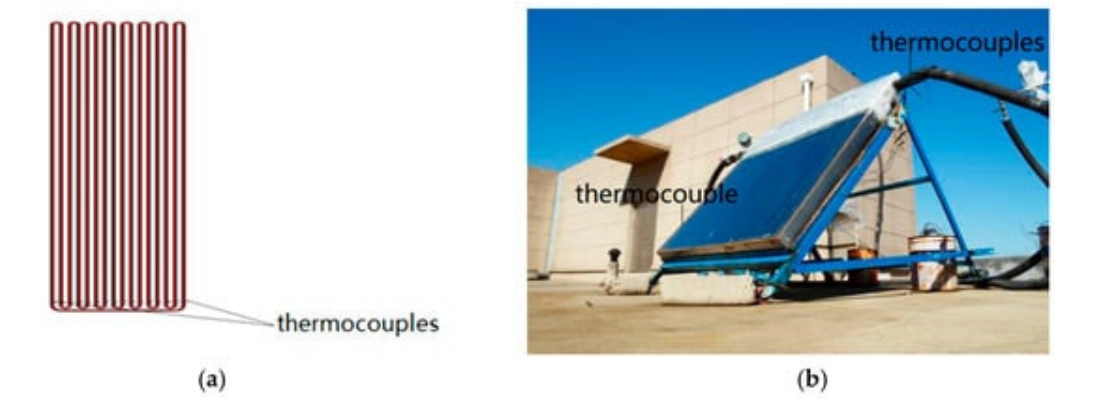
Figure 12. Schematic diagram of main parts and thermocouples’ ( a ) distribution on the absorber and cover ( b ) (reprinted from Reference [68] under the terms of the Creative Commons Attribution License CC BY 4.0 license, https://creativecommons.org/licenses/by/4.0/ (accessed on 25 October 2021)).